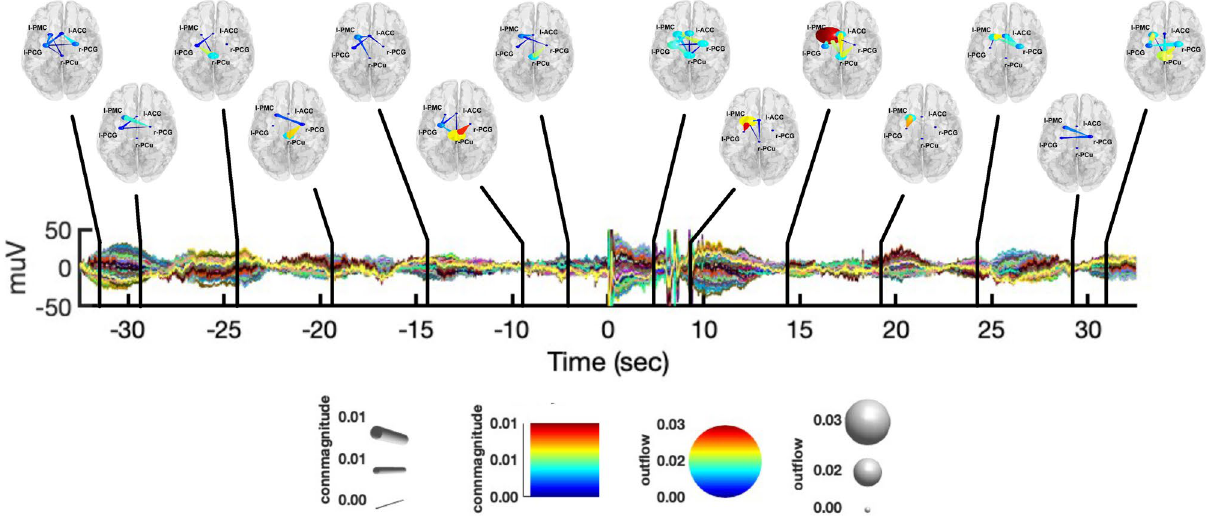
Figure 6. Graphical representation of causal interactions between the network nodes (i.e., l-PCG, l-PMC, r-PCu, l-ACC and r-PCG) integrated in the θ band, during both the resting-state from − 35 to − 5 s and CPT from + 5 to + 35 s, with respect to the CPT start. Nodes are reported in a standard template, with their corresponding label. Node size represent information outflow, whereas node color represents information inflow. The edges represent connections between nodes, whose color and size encode connectivity magnitude. The directionality of connections is given by the direction were the edges